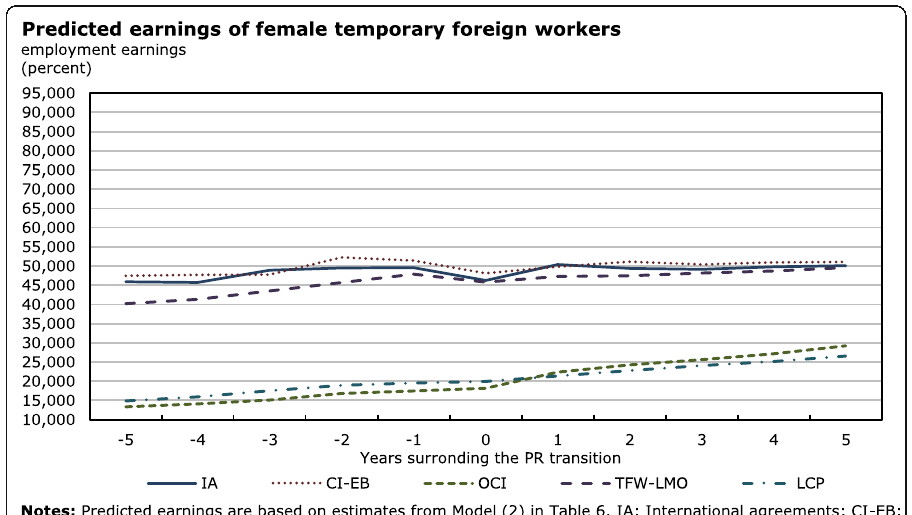
Fig. 8 Predicted earnings of female temporary foreign workers. Sources: Statistics Canada, Temporary Residents file, Immigrant Landing file and Canadian Employer-Employee Dynamics Database